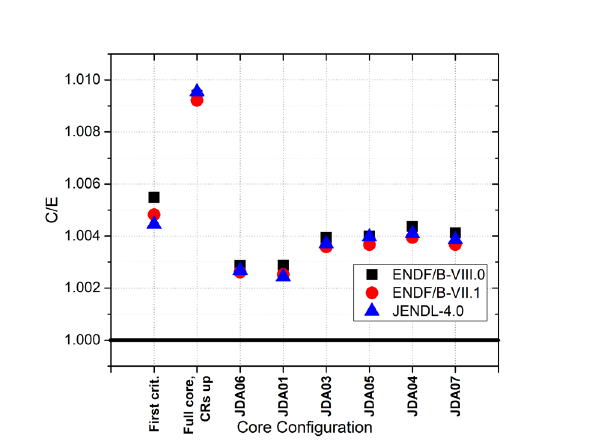
Figure 4. Impact of specific isotope ENDF / B-VIII.0 neutron